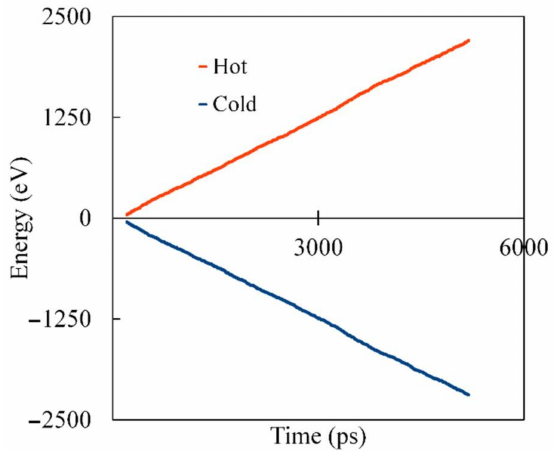
Figure 7. The energy-time graph for a sheet with the length of 33 nm. The heat flux in Equation (5) can be calculated based on the slope of each line. The slope of two drawn linear curves must be the same because the energy added in the hot source is equal to the energy removed in cold source during the simulations.